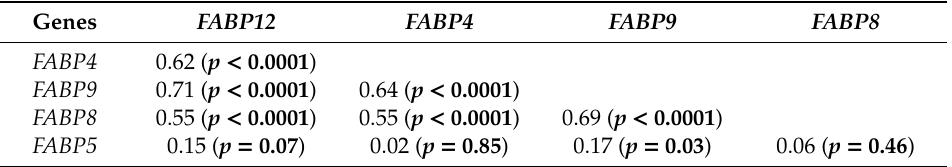
Table 2. Correlations in FABP levels between di ff erent members of the FABP family.